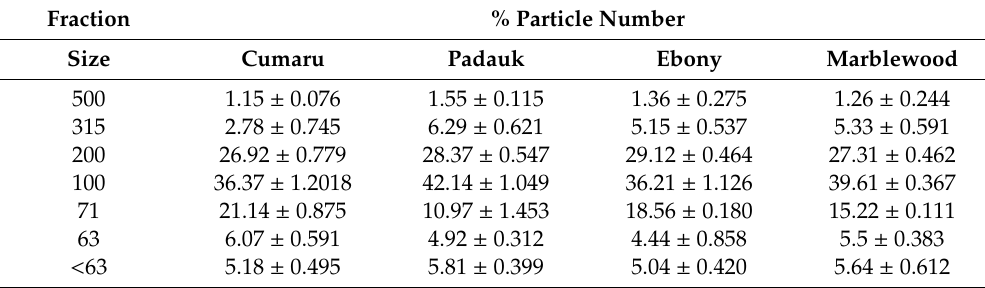
Figure 2. Continuous cumulative curve of cumaru, padauk, ebony, and marblewood dust. Table 3. Determination of % particle number fractions of the tropical wood